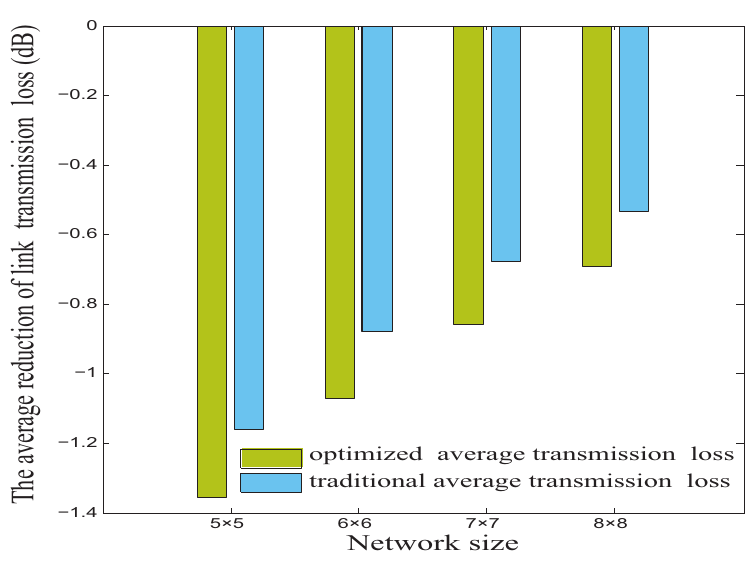
Figure 7. The average reduction of link transmission loss in M × N mesh-based ONoCs. The average output power of the transmitter in network links is P and the T ( x , y ) formula is shown in (26). M and N represent network sizes, and ( x , y ) represents the location of source node in network link. P represents the output power required by T ( x , y ) the optical transmitter of the source node in a network